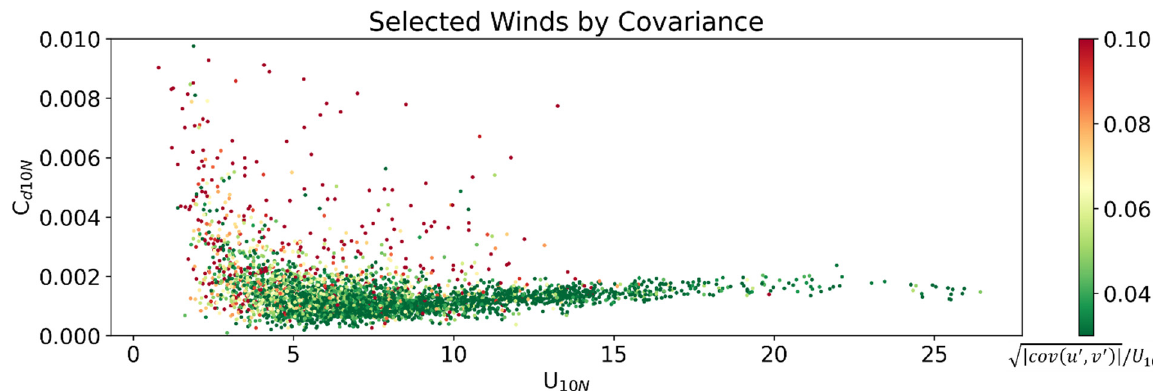
(cid:112) | cov ( u (cid:48) , v (cid:48) ) | / U 10